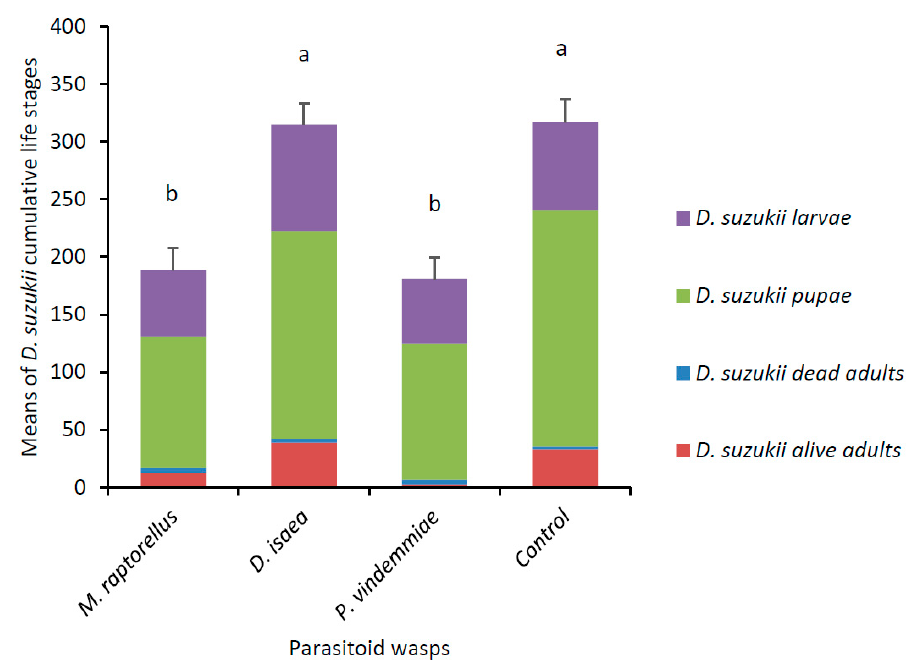
Figure 1. Means ( ± SE) of D. suzukii cumulative life stages (larvae, pupae, and dead and alive adults) recovered after 15 days when exposed to female parasitoid wasps. Each arena ( n = 8 per parasitoid wasp species) contained five D. suzukii mated females and raspberries at the beginning of the experiment, with 18 larval parasitoids added on day 4 and 18 pupal parasitoids added on day 9. Cumulative means with the same letter were not significantly different (Tukey’s HSD, p < 0.05). After 15 days, there was a significant effect of predator species on the total number of all D. suzukii life stages recovered (F 4,33 = 14.01, p < 0.0001). Orius insidiosus adults and C. carnea larvae reduced D. suzukii numbers by 49% and 32%, respectively, whereas D. hesperus and P. maculiventris did not significantly reduce D. suzukii cumulative life stages compared to the control (Figure 2). Predators O. insidiosus and C. carnea caused a decrease in the number of D. suzukii live adults ( χ 2 = 20.55, df = 4, p = 0.0004) and pupae (F 4,33 = 6.32, p = 0.0007). Predators O. insidiosus and D. hesperus decreased the number of D. suzukii larvae (F 4,33 = 6.91, p = 0.0004). Predator P. maculiventris did not have an impact on any of the D. suzukii life stages. At the end of the experiment, 4.5 ± 3.5 O. insidiosus , 2.4 ± 1.5 C. carnea , 13.0 ± 0.9 D. hesperus and 7.6 ± 1.7 P. maculiventris (mean ± SD) were recovered alive.